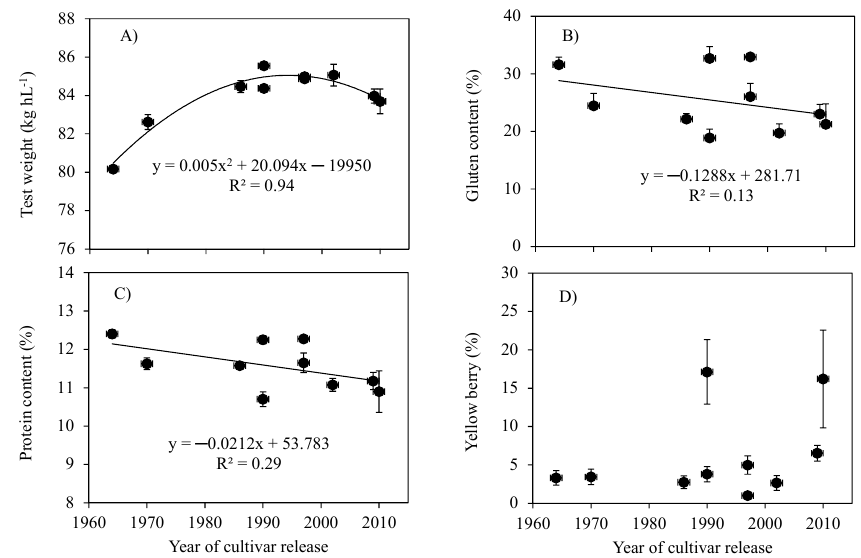
Figure 2. Relationships between the year of release of 10 durum wheat cultivars and kernel test weight ( A ), wet gluten content ( B ), protein content ( C ) and yellow berry ( D ), determined in 2010. Values correspond to the average (±SE) of four replicates.